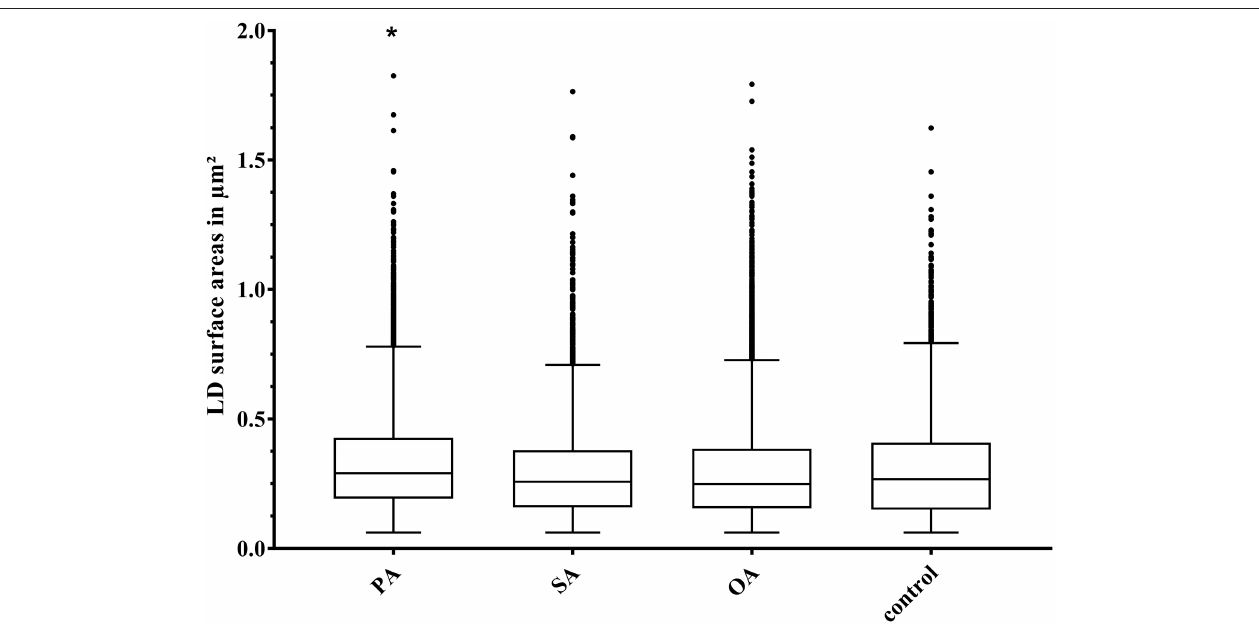
FIGURE 5 | Boxplot (median; 25th to 75th percentiles; min to max) of lipid droplet (LD) surface areas (in µ m 2 ) after different treatments. Asterisks significant difference between treatment and control ( p < 0.05). Dots indicate outliers; PA, palmitic acid ( N = 9,584); SA, stearic acid ( N = 5,008); OA, oleic acid ( N = 18,215); control ( N = 4,617); N , the number of evaluated LDs.